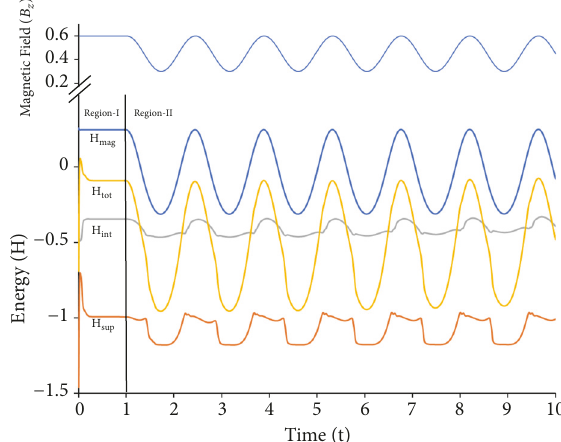
Figure 3: Temporal distribution of energy densities of cubic superconducting sample in static and oscillating magnetic fields, for cubic sample of side 20𝜉 each, with parameters 𝜅 = 4 and 𝜎 = 1 , and 𝐵 = 0.45𝜅 + 0.15𝜅 cos 𝜃 𝑧